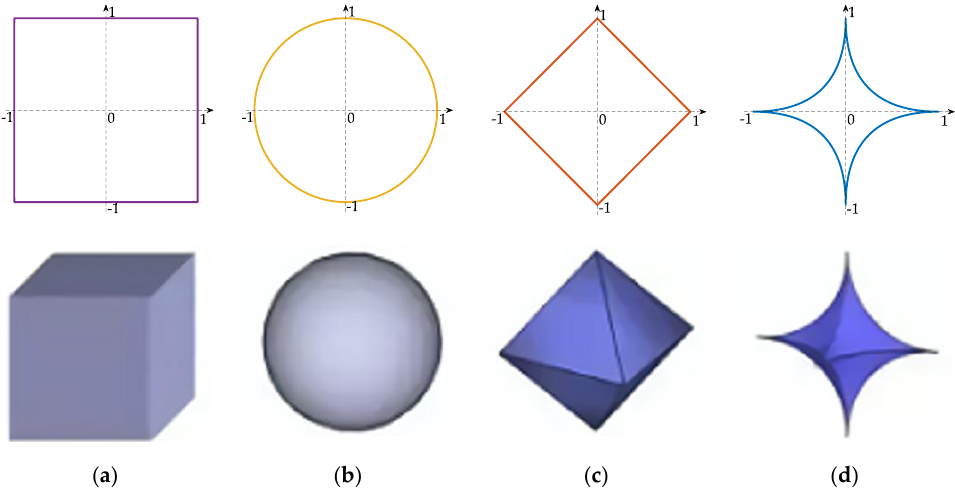
Figure 2. Unit circles and spheres of L p norms with p = ∞ , 2, 1 and 0.5 in R 2 and R 3 spaces; ( a ) p = ∞ ; ( b ) p = 2; ( c ) p = 1; ( d ) p = 0.5.